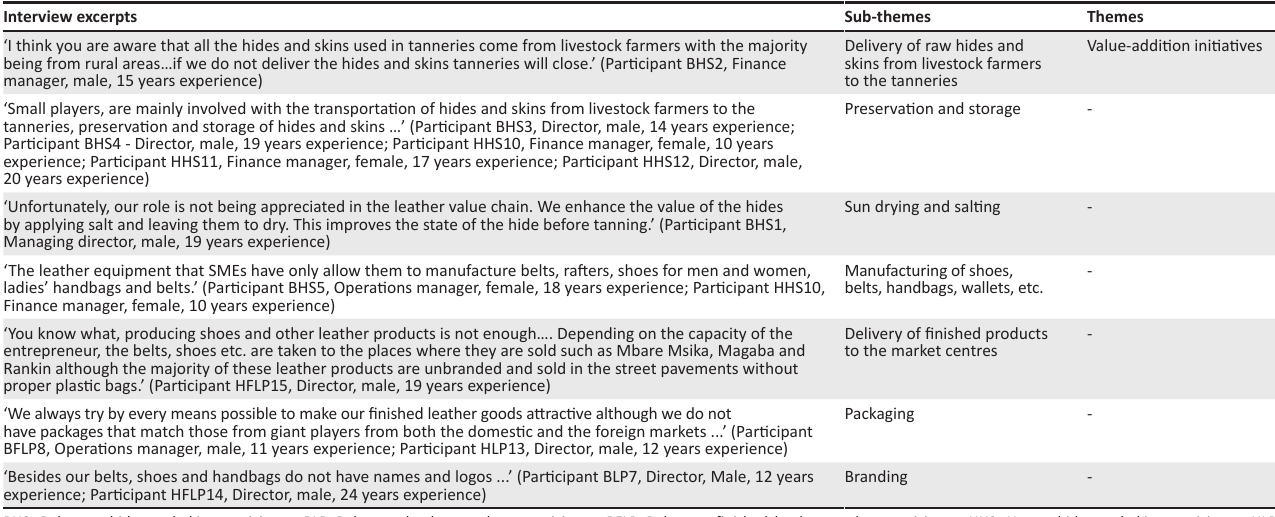
TABLE 3: Theme 1 value-addition initiatives.